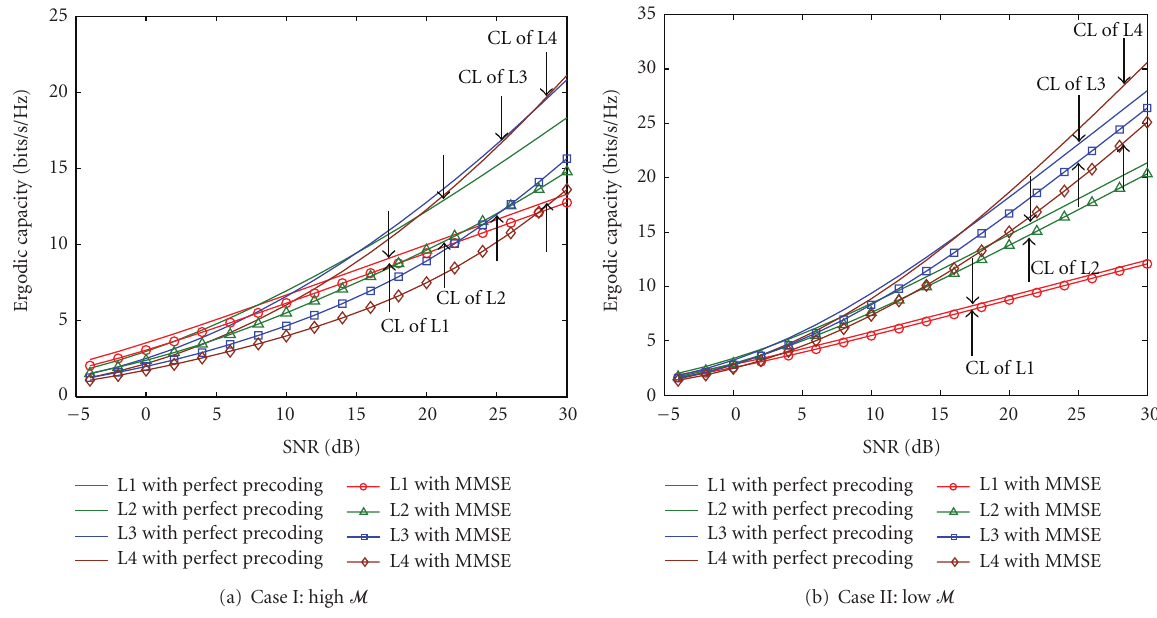
Figure 6: CL comparison between di ff erent layer transmissions with MMSE receiver using CLSM codebook.